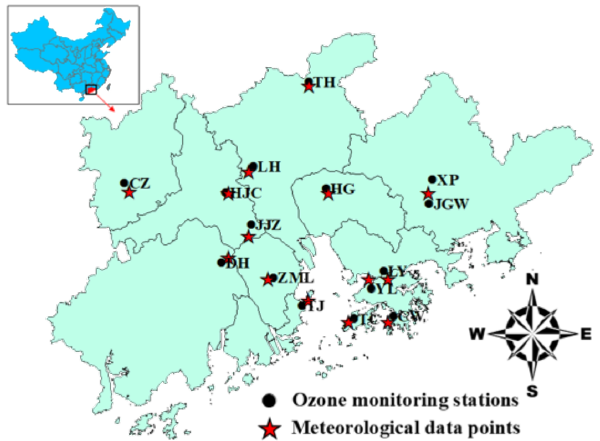
Figure 1. Distribution of the ozone monitoring stations and meteo- rological data points in the Pearl River Delta.